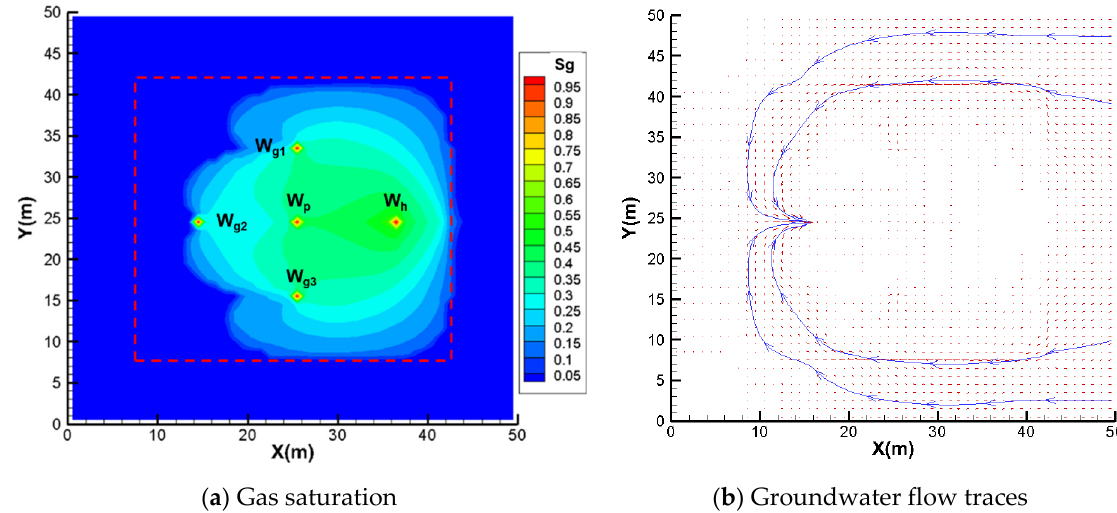
Figure 8. Gas saturation nephogram and groundwater flow traces in the gas flooding pressure of 3 MPa.